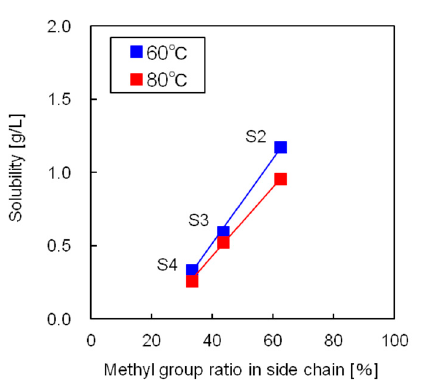
Figure 6. Influence of the side chain methyl group ratio on silicone resin solubility.